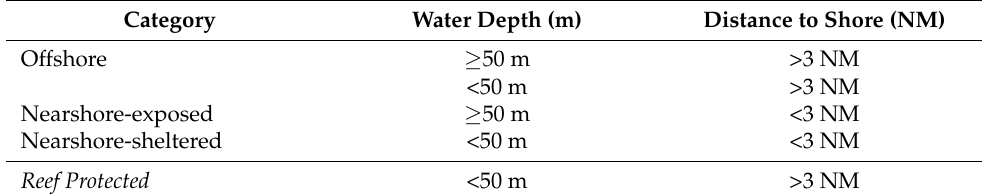
Table 1. Aquaculture environment